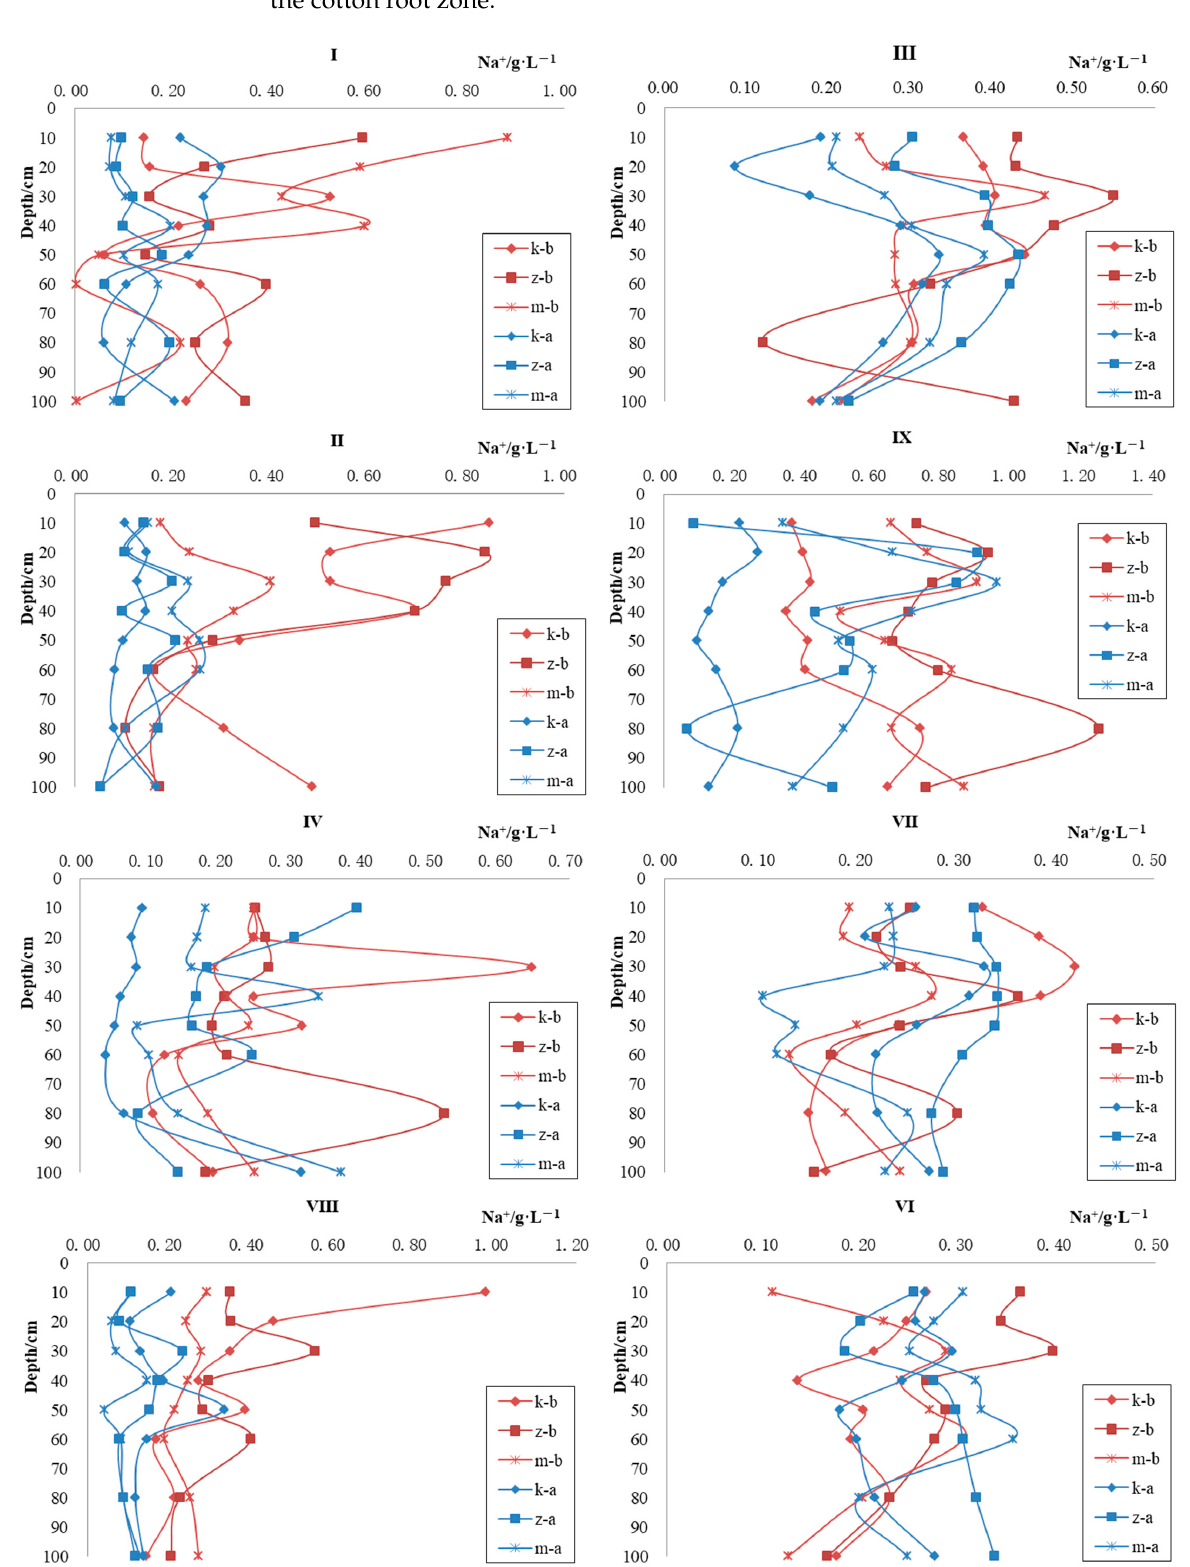
Figure 4. Na + distribution of soil profile in each irrigation scenario before and after the fourth irrigation. Note: the representative meaning of the legend is the same as that in Figure 2.